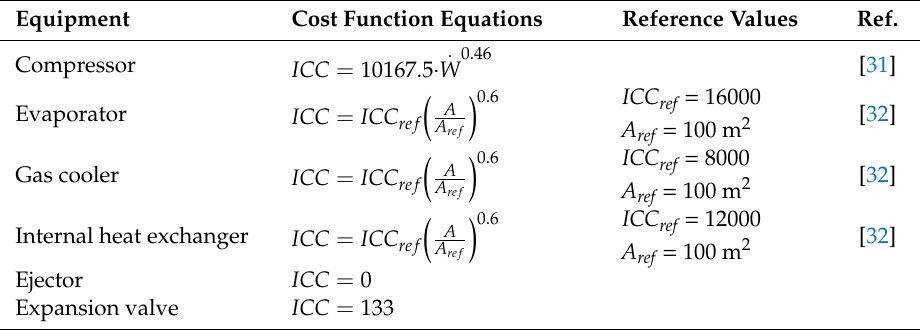
Table 2. Cost function equations of the equipment considered in the refrigeration cycles.